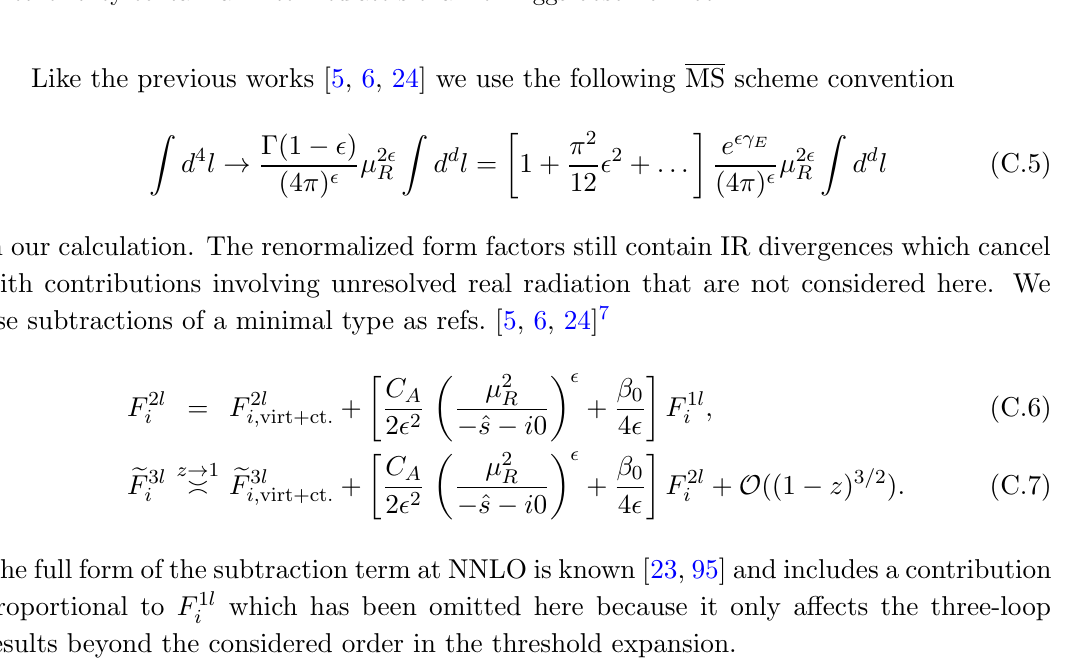
Figure 11 . The Feynman diagrams are divided into ‘triangle’ and ‘box’ topologies depending on whether they contain an intermediate s-channel Higgs boson or